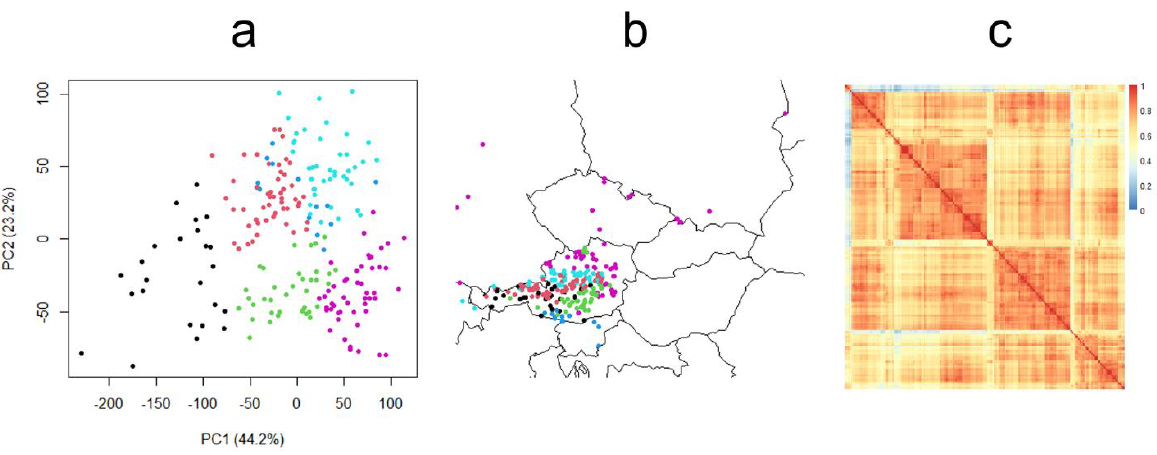
Figure 2. ( a ) Plot of the first and second principal components (PCs) from principal component analysis (PCA) of population provenances based on geospatial and climatic data. ( b ) Map of population provenances. Points in ( a , b ) were labeled based on the five clusters identified by hierarchical clustering. ( c ) Population provenance climatic similarity matrix, with off-diagonal cells representing the similarity between pairs of populations. Pairwise similarities are colored on a heatmap. The matrix was organized by hierarchical clustering.